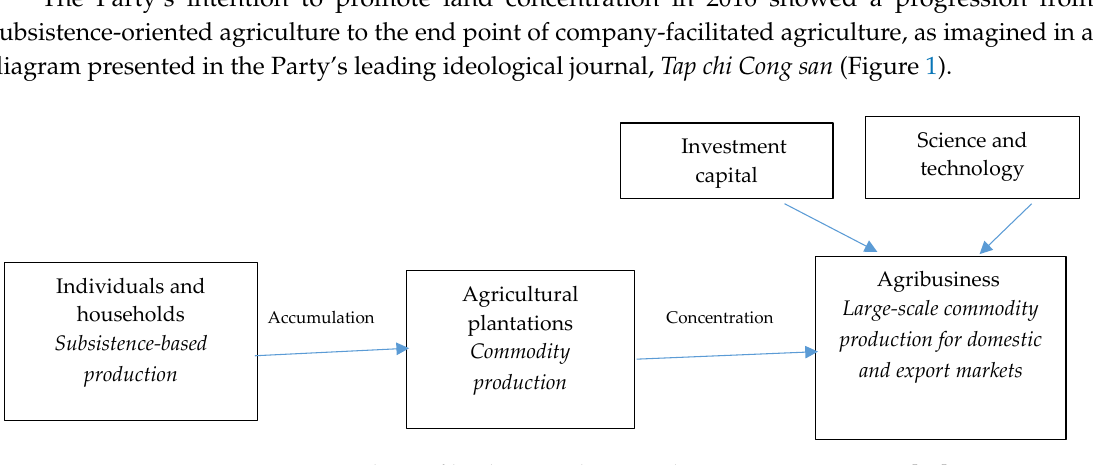
Figure 1. Government’s logic of land accumulation and concentration. Source: